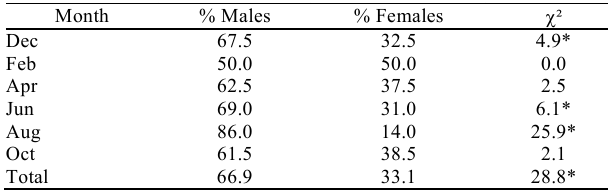
Table 2. Sex ratio by bi-monthly period for Plagioscion magdalenae in the bay of Marajo. *Significant at 5%